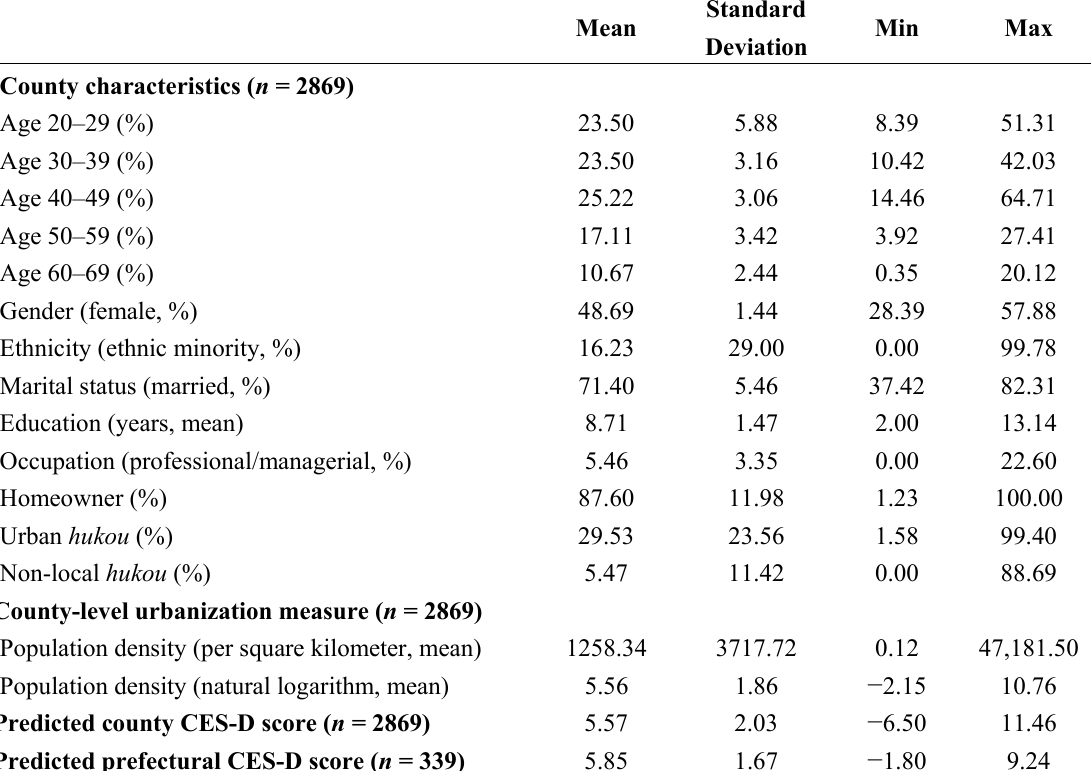
Table 3. Descriptive statistics of county characteristics, county-level urbanization measure, and predicted county and prefectural CES-D